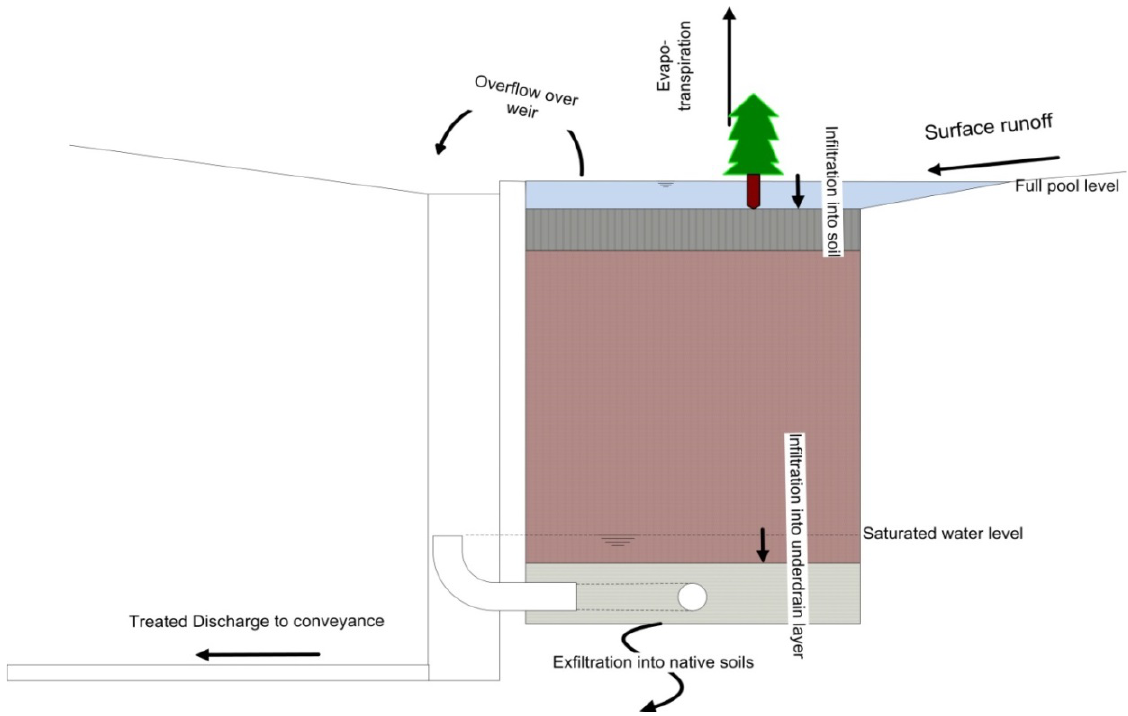
Figure 2. Schematic diagram of a bioretention facility and its hydraulic pattern.